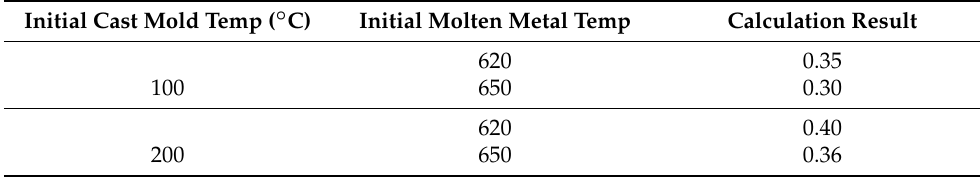
Table 8. Calculation result of the solid fraction at the flow